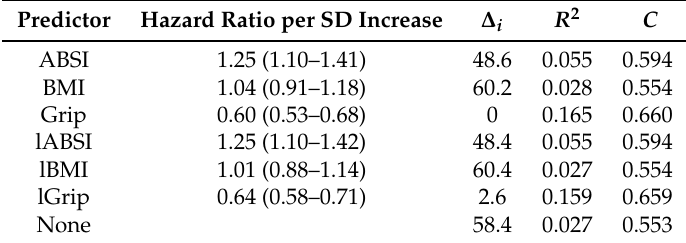
Table 2. Mortality hazard association with body and strength